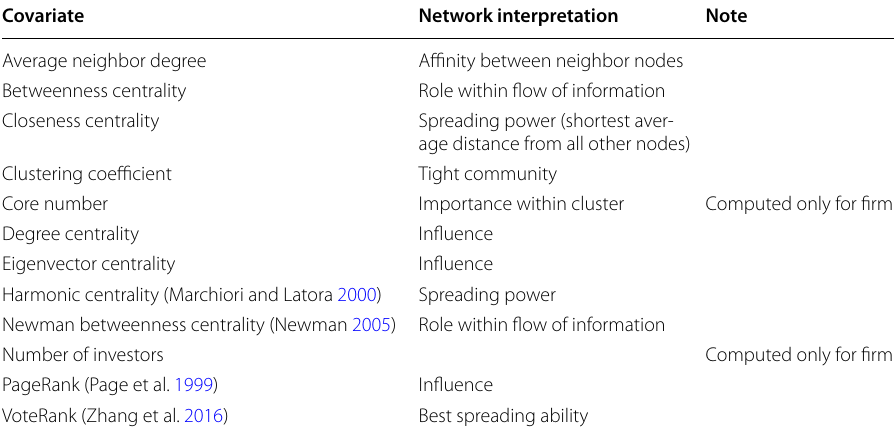
Table 1 Statistics computed on the projected graphs of investors and